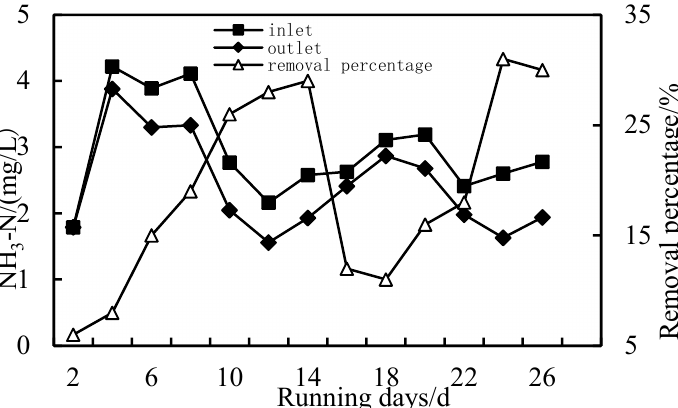
Figure 7. Removal of NH 3 -N with PAC-HUM.